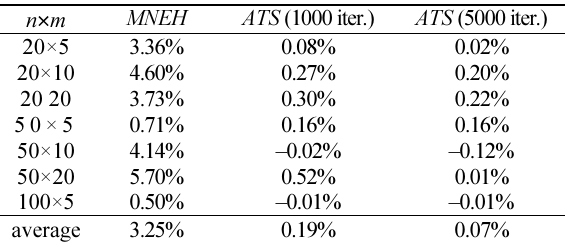
Table 4. The percentage relative effort of the tabu search and the MNEH algorithms as against Taillard’s solutions